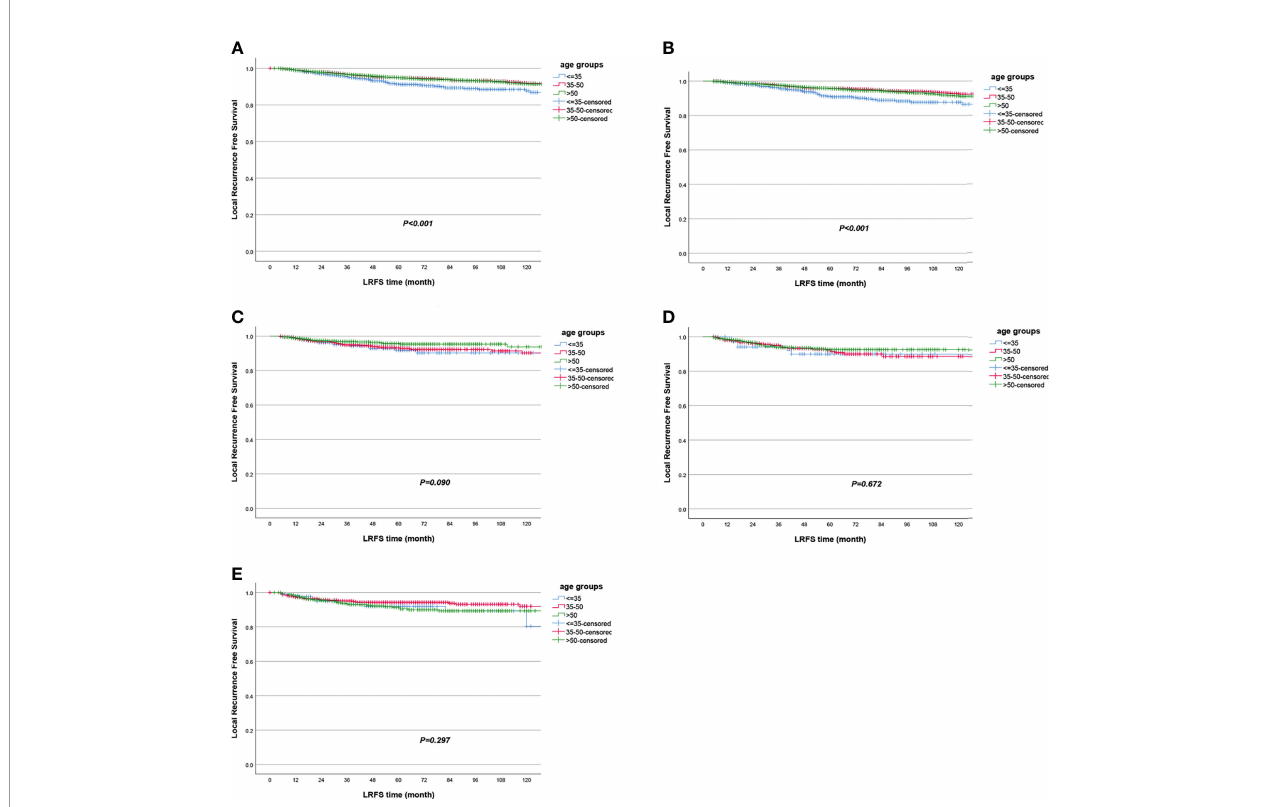
FIGURE 2 | Local recurrence-free survival according to age groups in (A) all patients and in subgroup analyses strati fi ed by (B) HR+/HER2 − , (C) HR+/HER2+, (D) HR − /HER2+, and (E) triple